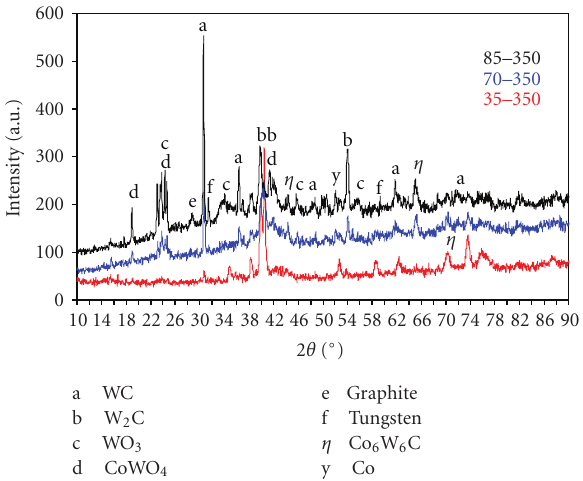
Figure 7: X-ray di ff raction pattern of WC-17Ni